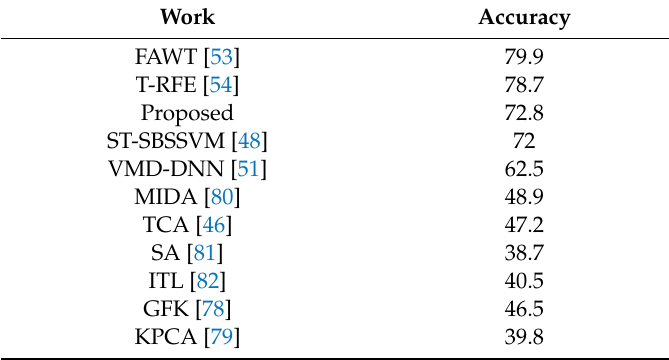
Table 6. One-subject-out accuracy comparison of several studies for the DEAP dataset